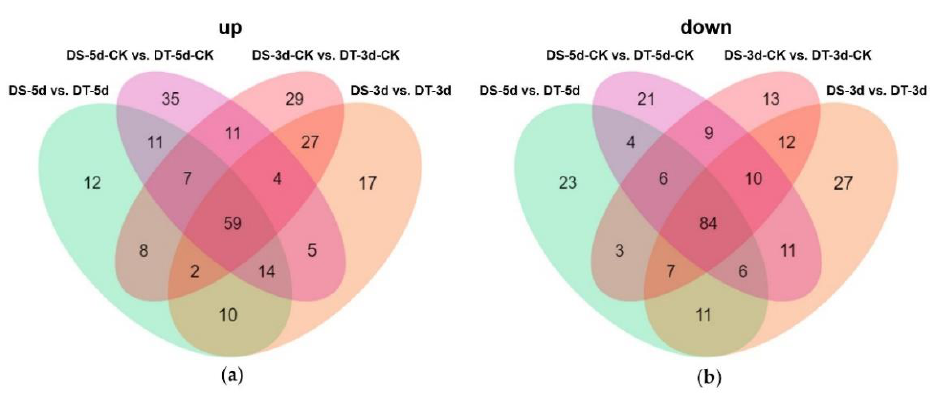
Figure 8. Venn diagram showing the number of upregulated ( a ) and downregulated ( b ) differential metabolites (DMs) between DS and DT under control and drought conditions.